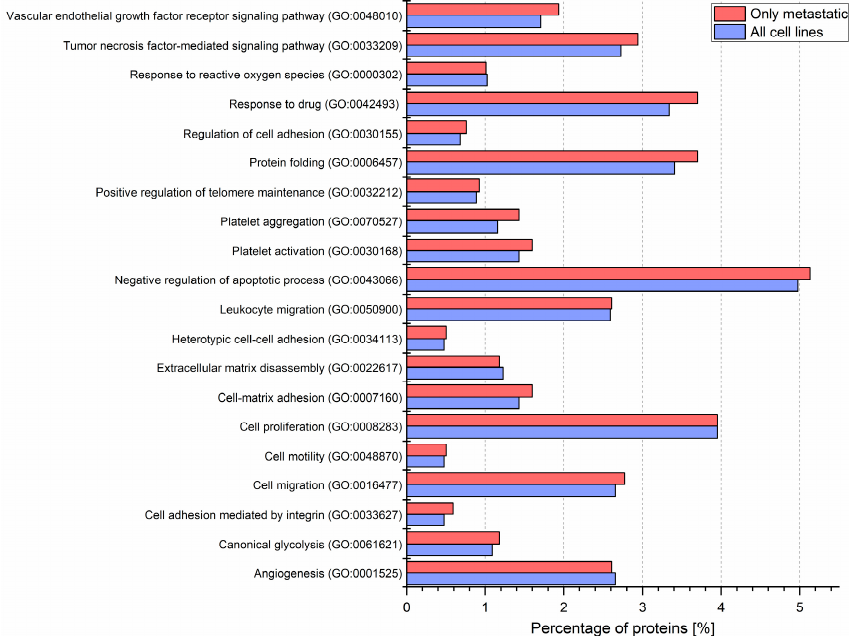
Figure 5. Gene ontology annotations by the biological process for each CM ectosome sample performed via UniProt (release 2019_11) database. Percentages of proteins within the chosen cancer- related categories for ectosomes from all or metastatic cell lines are presented on the graph. Ectosomes were isolated from WM115 (primary) and WM266-4 (metastatic) cell lines originating from the same individual, radial/vertical growth phase and lymph node metastasis, respectively; primary WM793 cell line, representing vertical growth phase; and WM1205Lu, a metastatic variant of WM793 cells obtained from lung metastasis.